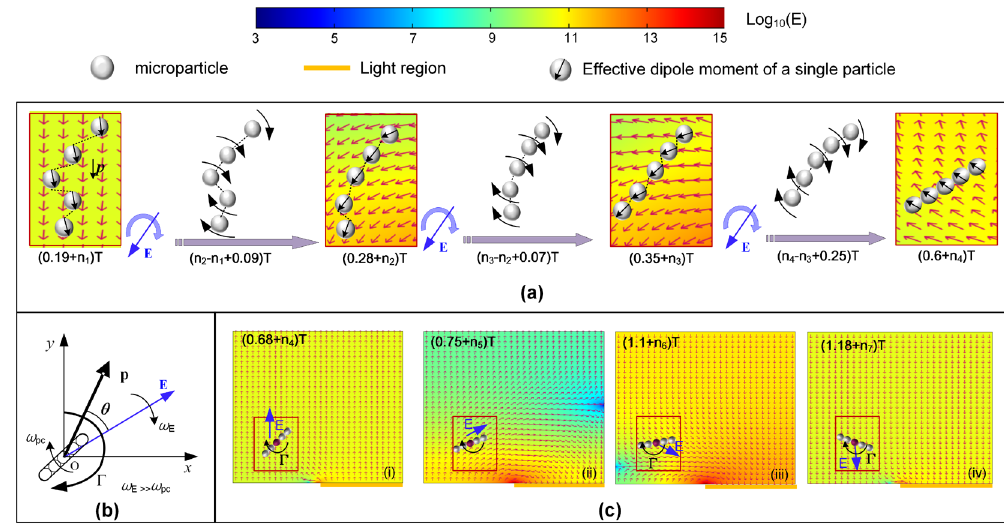
Figure 5. Analysis for particle chain formation and rotation based on the numerical simulation results of the rotating electric field. ( a ) Illustration and analysis of the process for particle chain formation. It includes rotational and translational motion of surrounding particles relative to the central of this structure. ( b ) Elucidation of the interaction between the polarized particle chain and the rotating vector E . ( c ) Illustration of the rotation of particle chain relative to its geometry center in rotating e-field at different time instants. n 1 , n 2 , n 3 , n 4 are integers and indicate the different number of signal cycles that the particles experienced. T denotes the period of applied AC signal. The size of simulation domain is set 60 μm (width) × 100 μm (height), and the width of light region is set 30 μm. The amplitude and frequency are set 5 V and 700 kHz respectively.